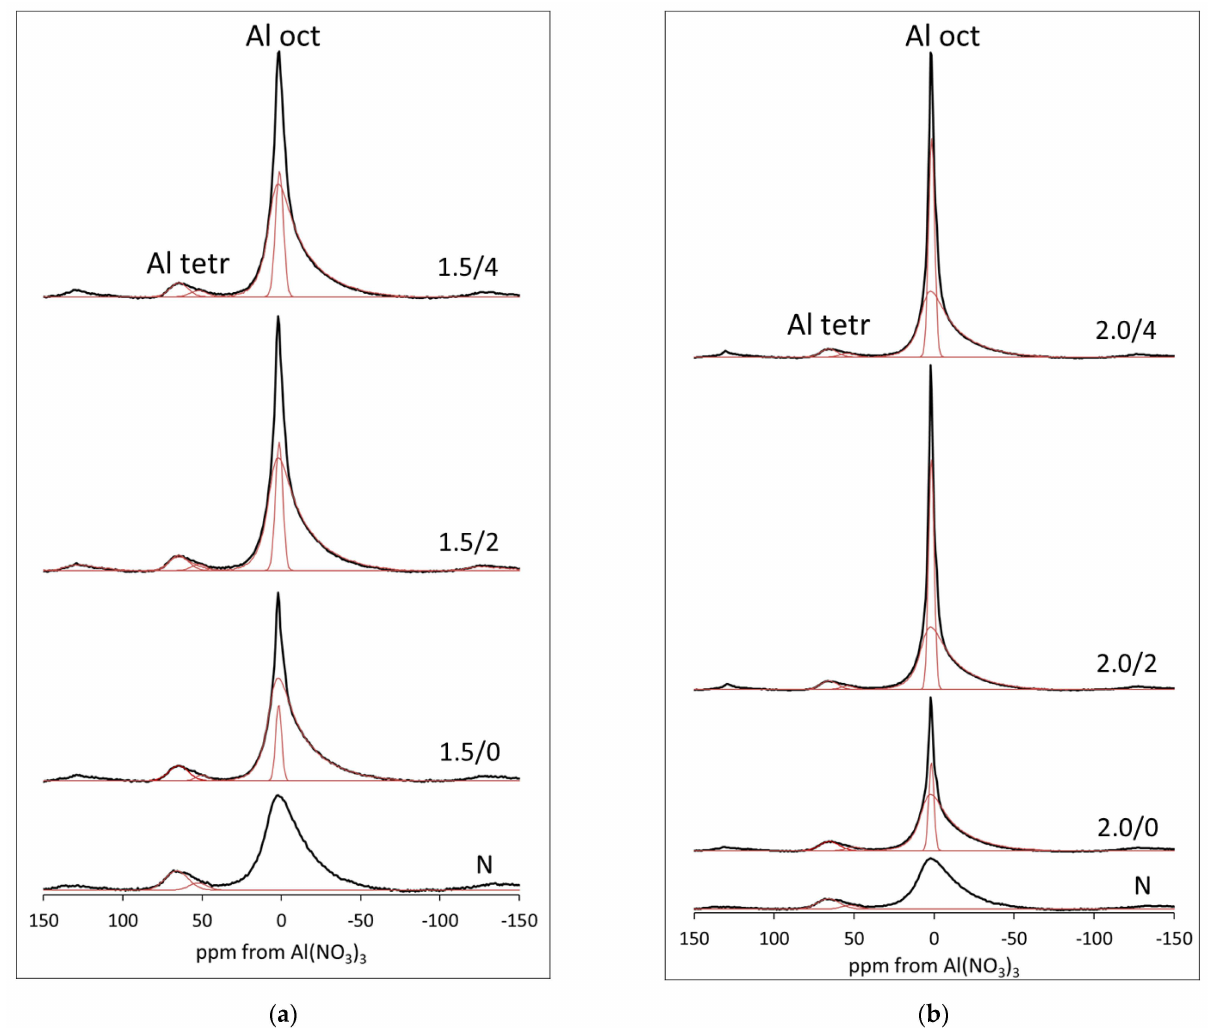
Figure 4. Evolution of 27 Al MAS NMR spectra of bentonite impregnated with H 2 SO 4 with time of aging: ( a ) series treated with H 2 SO 4 of concentration corresponding to 1.5 × CEC ( b ) series treated with H 2 SO 4 of concentration corresponding to 2.0 × CEC.